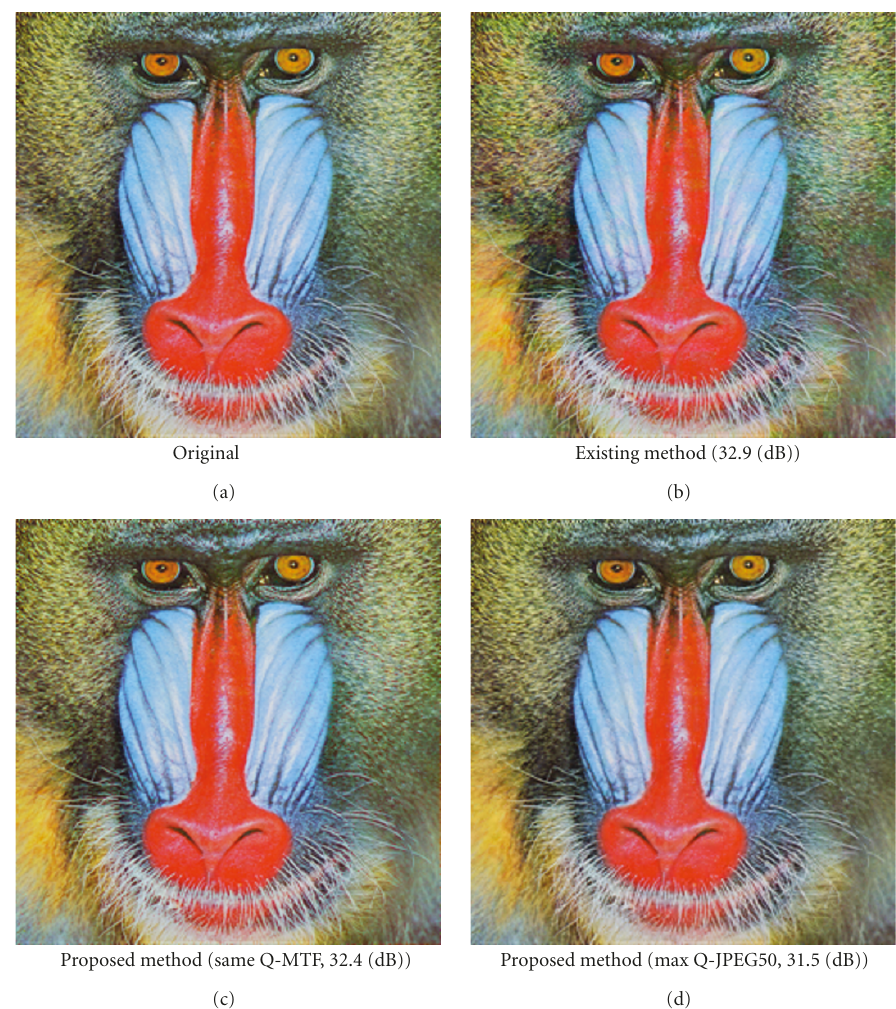
Figure 14: Comparison in the image quality.